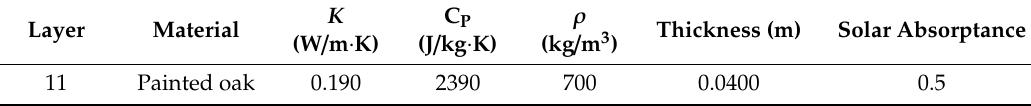
Table A1. Building materials for roof construction. Layer 0.8 Table A2. Building materials for floor construction. Layer